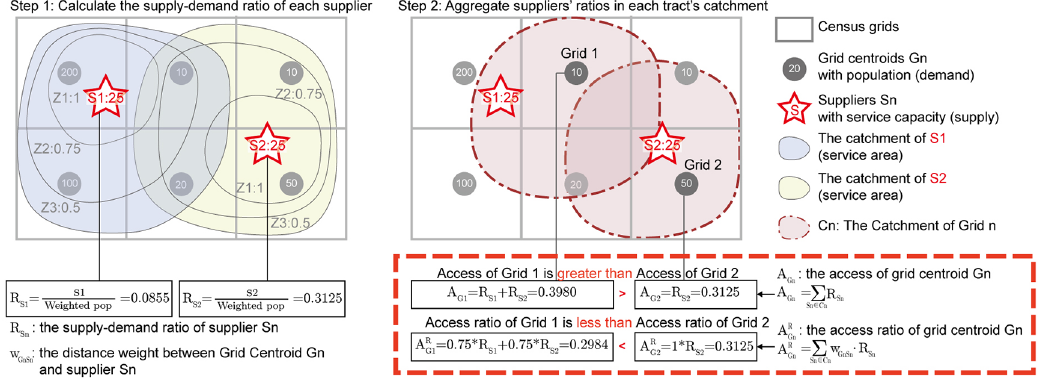
Figure 2. Comparison of accessibility values as the sum of supply-demand ratios ( A i ) and the sum of weighted supply-demand ratios ( A R i ). A R i enlarges the resource acquisition of grids closer to supplier ’ s